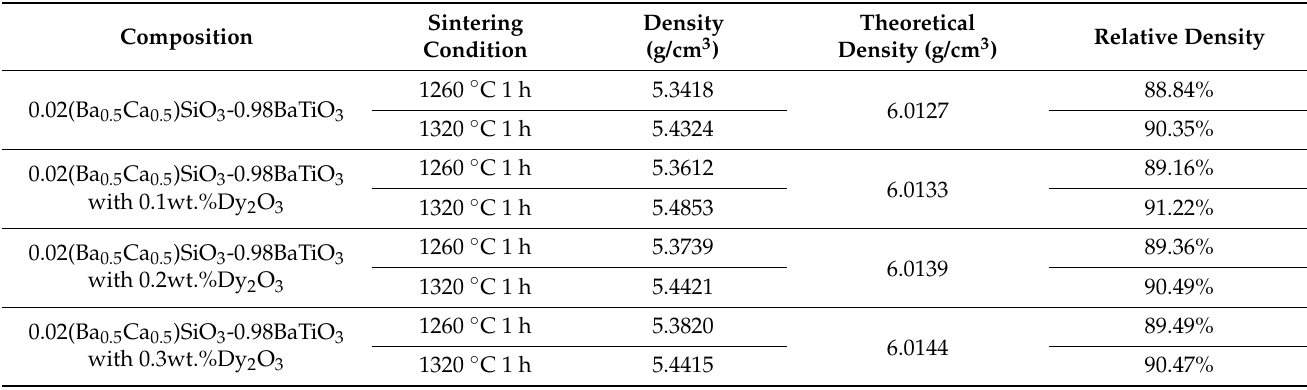
Table 3. Relative densities of the 0.98BaTiO 3 -0.02(Ba 0.5 Ca 0.5 )SiO 3 ceramics with different Dy 2 O 3 additive contents without binder solution and sintering